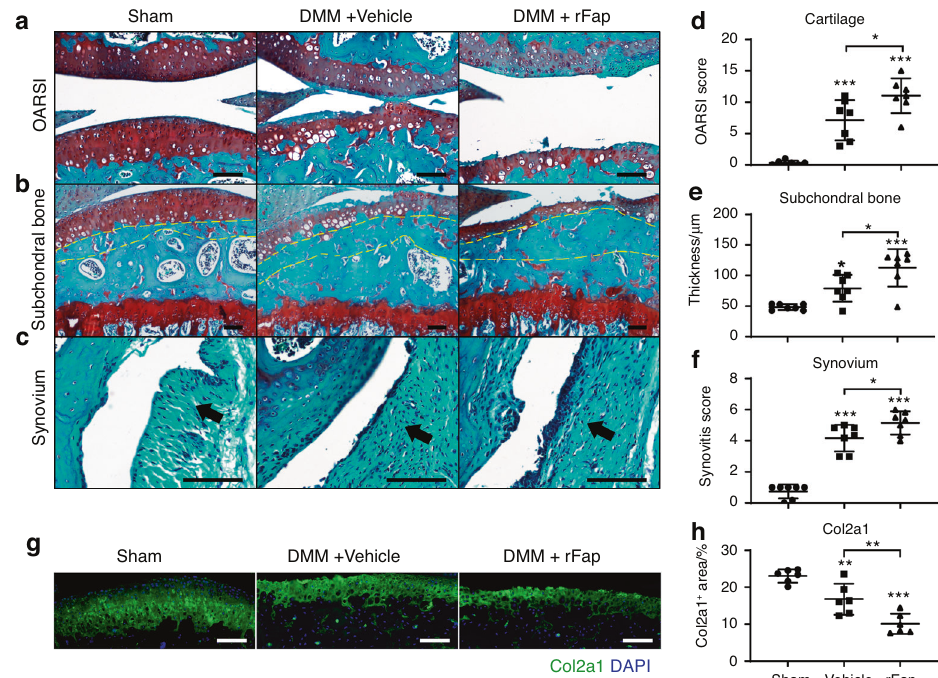
Fig. 5 rFap accelerates joint symptoms after the onset of OA. a – c Safranin O/Fast Green staining in wild-type mice administered rFap or vehicle after DMM surgery. Weekly intra-articular administration of rFap (40 μ g/kg body weight) or vehicle (PBS) was performed 4 weeks after DMM surgery in 10-week-old mice and continued for 8 weeks before paraf fi n sectioning and safranin O/fast green staining of the knee joints. Representative cartilage erosion ( a , top: femur, bottom: tibia), subchondral bone thickening ( b ) and synovitis ( c ) images are shown ( n = 7 mice per group). Yellow dotted lines indicate the subchondral bone plate. Arrows indicate the synovium. Scale bars: 100 μ m. d – f Quanti fi cation of the OARSI score ( d ), subchondral bone thickness ( e ) and synovitis score ( f ). g , h Immunostaining of Col II in the knee joints ( g ) with quanti fi cation ( h ) ( n = 6 mice per group). DAPI staining indicates the nucleus. Scale bars: 100 μ m. The statistical signi fi cance was assessed using one-way ANOVAs with Tukey ’ s multiple comparison tests. Data are presented as the mean ± SD (* P < 0.05, ** P < 0.01, *** P <